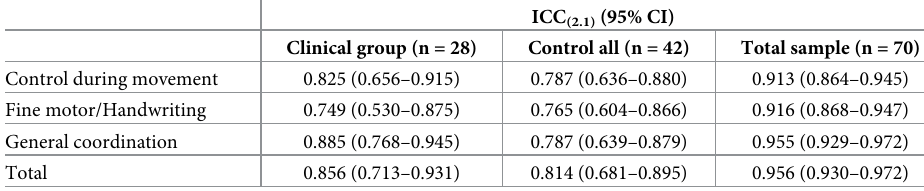
Table 3. Test-retest subcategories and total scores